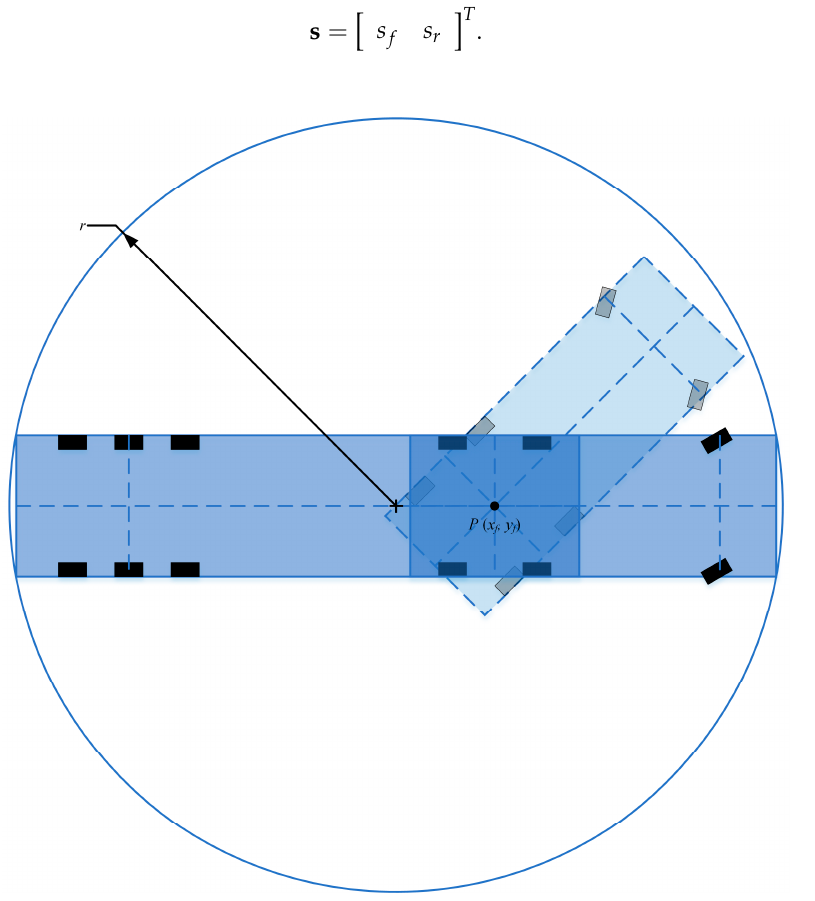
Figure 3. The circumcircle model of the semi-trailer.